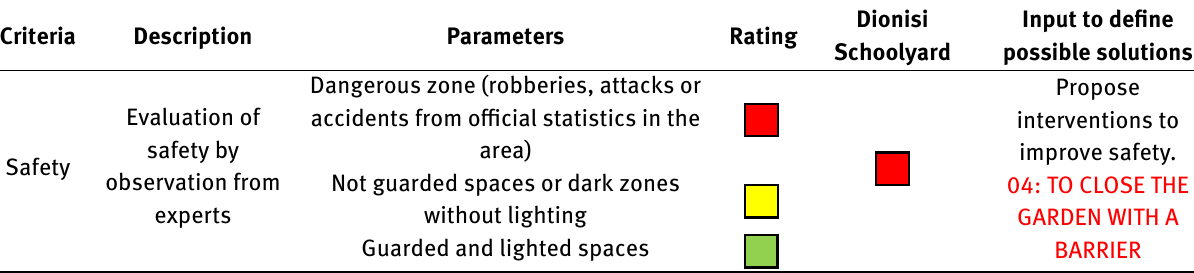
Table 3: Expert analysis-ante operam scenario for the pilot cases selected in Florence (Dionisi schoolyard).